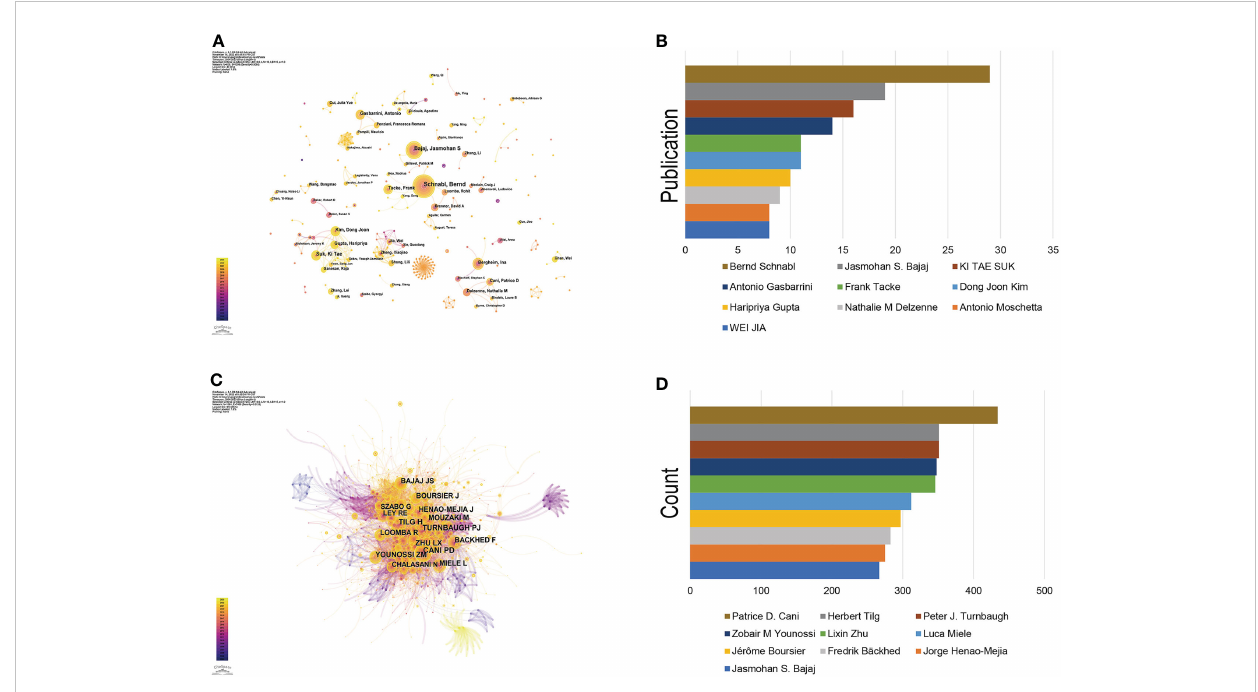
FIGURE 4 Authors involved in the study of the gut-liver axis in NAFLD. (A) Visualization of co-occurrence of authors based on CiteSpace. (B) Top 10 authors in terms of number of publications. (C) A visual map of co-cited authors based on CiteSpace. (D) Top 10 authors in terms of